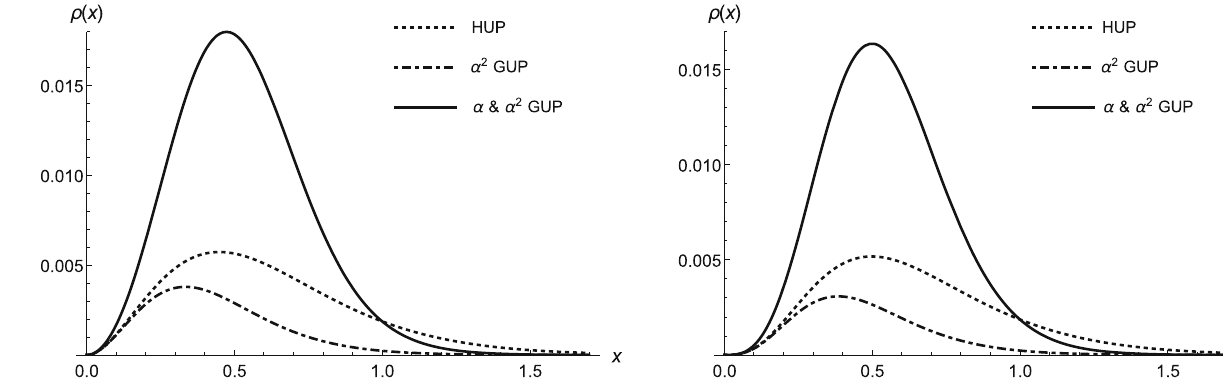
Fig. 4 The total energy density ρ( x ) versus the variable x for massless bosonsinageneralstaticsphericallysymmetricspacetime,where a = 1 with a = 2 πα T .Thisintegralisnoteasytobeexactlysolved,